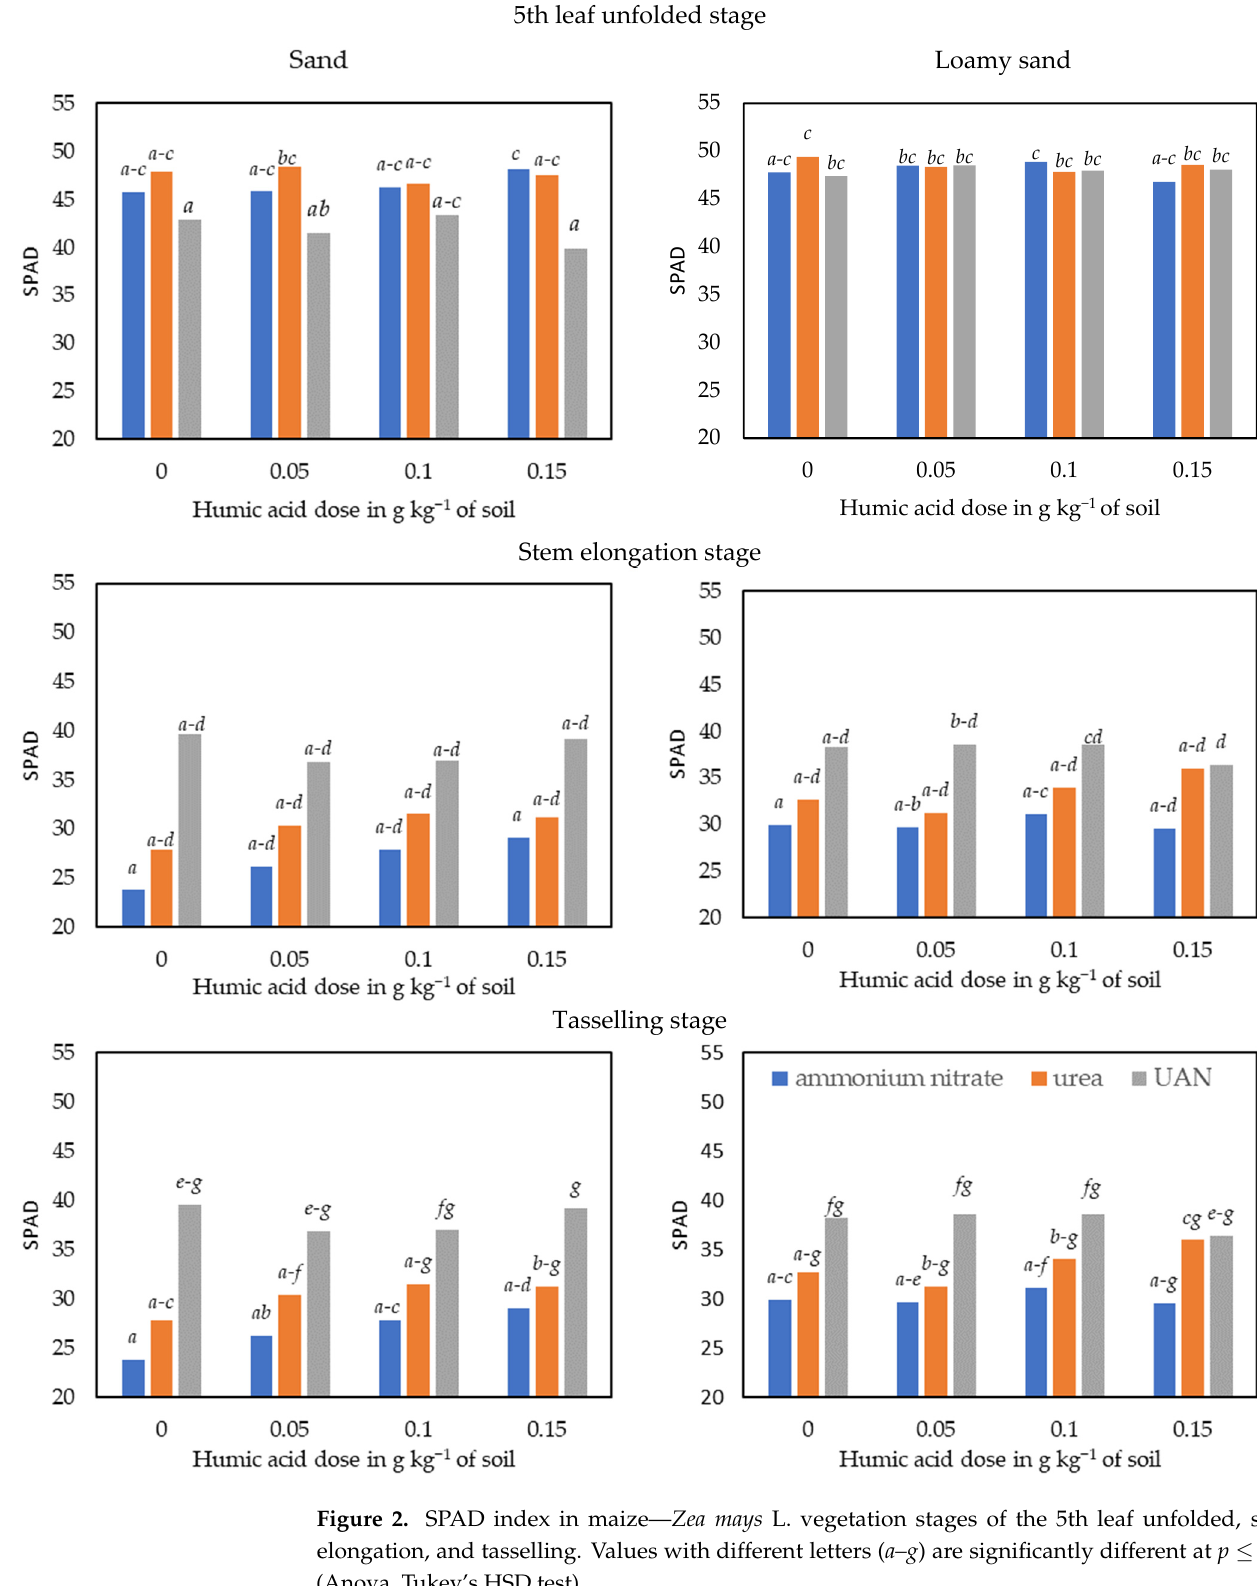
Figure 2. SPAD index in maize— Zea mays L. vegetation stages of the 5th leaf unfolded, stem elongation, and tasselling. Values with different letters ( a–g ) are significantly different at p ≤ 0.01 (Anova, Tukey’s HSD test).